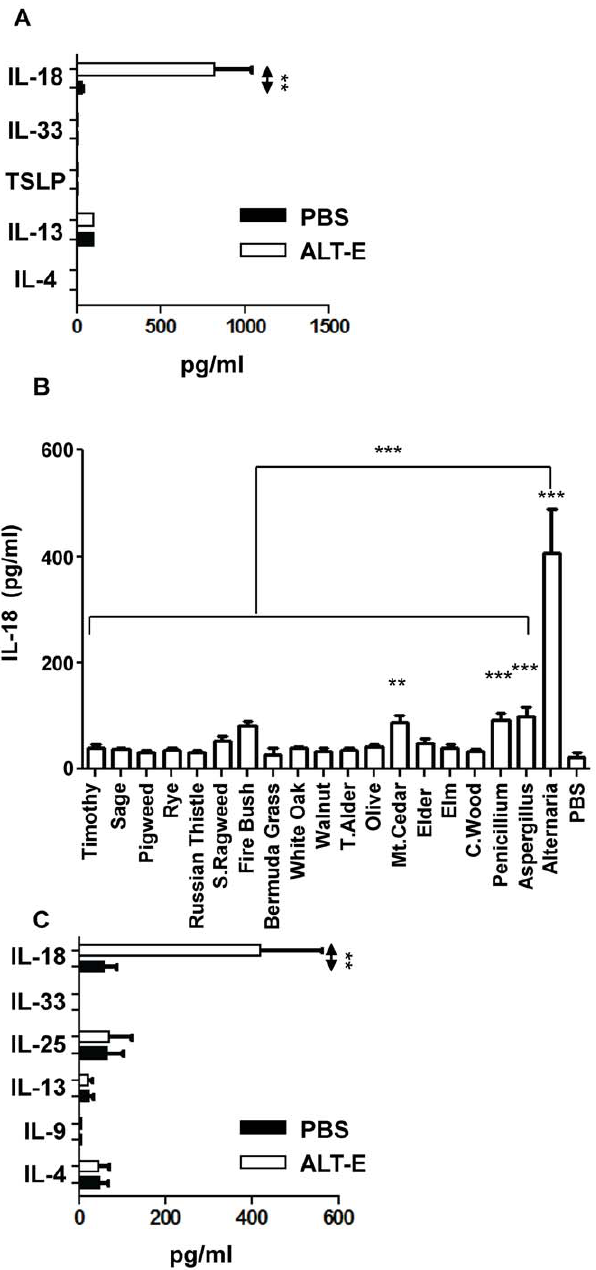
Figure 1. Rapid release of cytokines from epithelial cells cultured with ALT-E. ( A, B ) NHBE cells were cultured with PBS, ALT-E or other allergens for 15 min, and released cytokines were quantified. T. Alder, Tag Alder; S. Ragweed, Short Ragweed (n=5 wells per treatment group). ( C ) BALF cytokine levels in naı¨ve mice 60 min after challenge with 20 m g ALT-E or PBS control (n=4 per